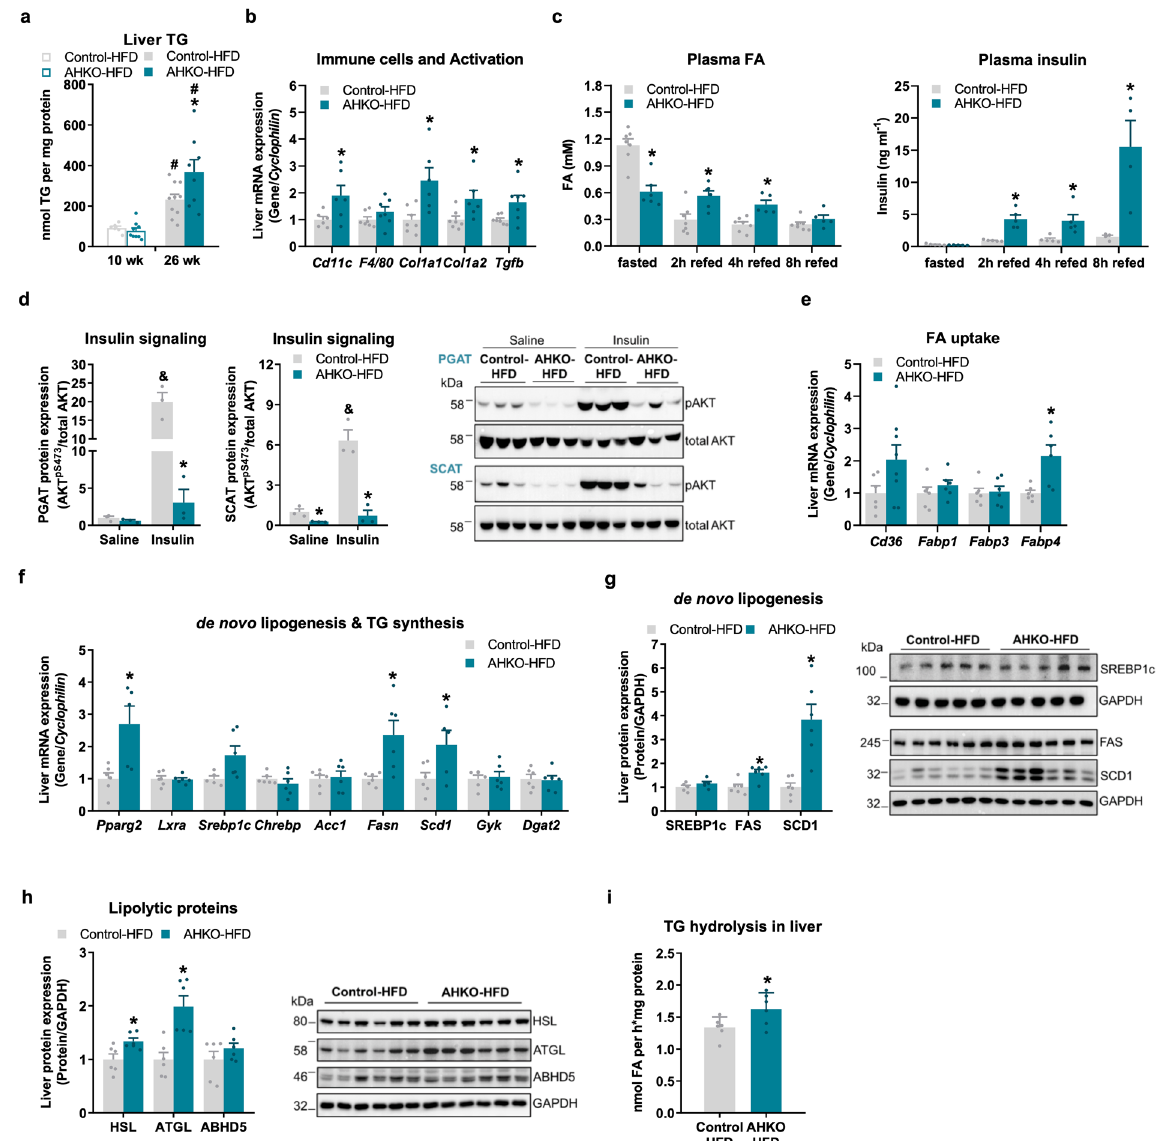
Fig. 3 Effects of adipocyte-speci fi c HSL deletion on hepatic lipid homeostasis. a Hepatic triglyceride (TG) content (M, 10 and 26 weeks, HFD, ad libitum fed, n = 6 – 10 animals/genotype). b Liver mRNA expression of immune cell markers and genes involved in fi brosis relative to Cyclophilin reference gene by qPCR with control animals arbitrarily set to 1 for each gene (M, 26 weeks, HFD, ad libitum fed, n = 5 – 6 animals/genotype). c 12 h fasted and refed plasma fatty acid (FA; left) and insulin (right) levels (M, HFD, 17 weeks, n = 4 – 7 animals/genotype). d Insulin signaling in WAT. Mice were injected with saline or insulin at 0.75 IU kg − 1 body weight. Left: quanti fi cation of phosphorylation of AKT pSer473 /total AKT in PGAT and SCAT (M, 26 weeks, HFD, 12 h fasted, n = 3 animals/genotype). Right: representative immunoblots. e Hepatic mRNA expression of FA transporter in the liver (M, 22 weeks, HFD, ad libitum fed, n = 6 – 8 animals/genotype) and f genes involved in de novo lipogenesis and triglyceride (TG) synthesis relative to Cyclophilin reference gene by qPCR with control animals arbitrarily set to 1 for each gene (M, 26 weeks, HFD, ad libitum fed, n = 5 – 6 animals/genotype). g Left: liver expression of proteins involved in de novo lipogenesis (SREBP1c, FAS, SCD1). Right: representative immunoblots (M, 26 weeks, HFD, ad libitum fed, n = 6 animals/genotype). h Left: liver protein expression of lipolytic proteins (HSL, ATGL, ABHD5). Right: representative immunoblots (M, 26 weeks, HFD, ad libitum fed, n = 6 animals/ genotype). i Triglyceride hydrolase activity in liver determined by [ 3 H]-labeled oleic acid release (M, 26 weeks, HFD, ad libitum fed, n = 4 – 5 animals/ genotype). Data represent mean + SEM. Statistical signi fi cance was determined by Student ’ s two-tailed t test. P < 0.05: * for effect of genotype; # for effect of age; & for effect of